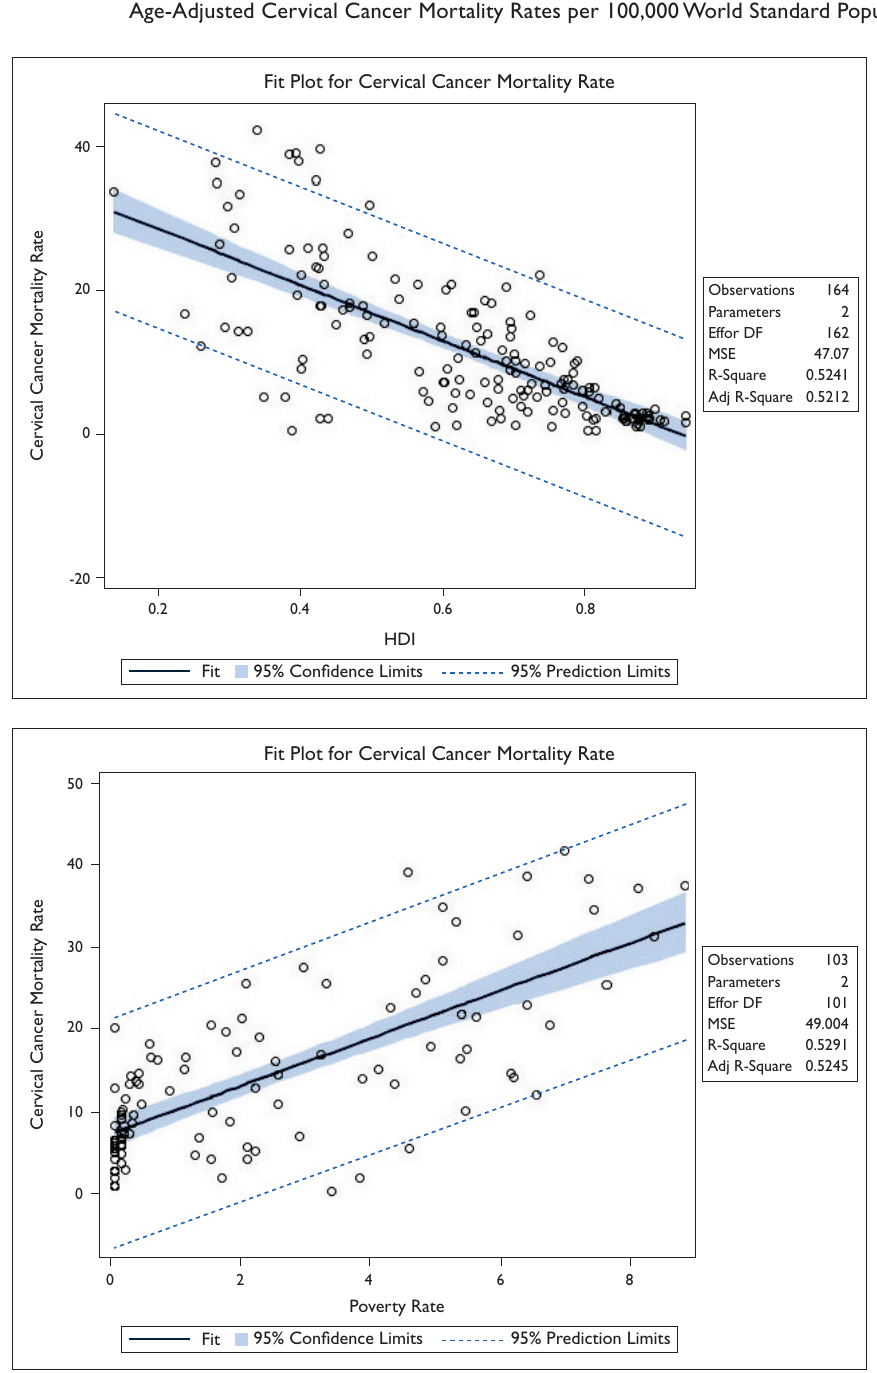
Figure 4. Observed and Fitted Plots Showing the Impact of Human Development Index (HDI) and Poverty on Age-Adjusted Cervical Cancer Mortality Rates per 100,000 World Standard Population, 2008 Fit Plot for Cervical Cancer Mortality